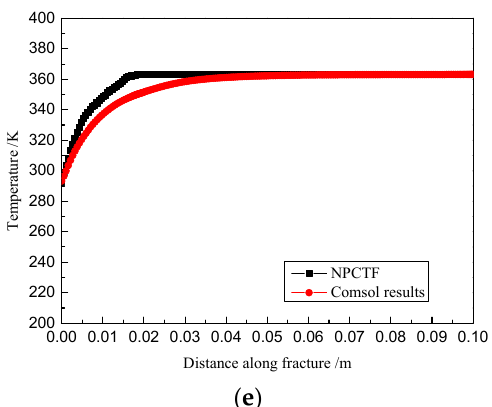
Figure 4. Temperature distribution along 5 fracture profiles calculated by the proposed NPCTF and COMSOL with different joint roughness coefficient (JRC) values. ( a ) JRC = 1; ( b ) JRC = 5; ( c ) JRC = 10; ( d ) JRC = 15; ( e ) JRC = 20.